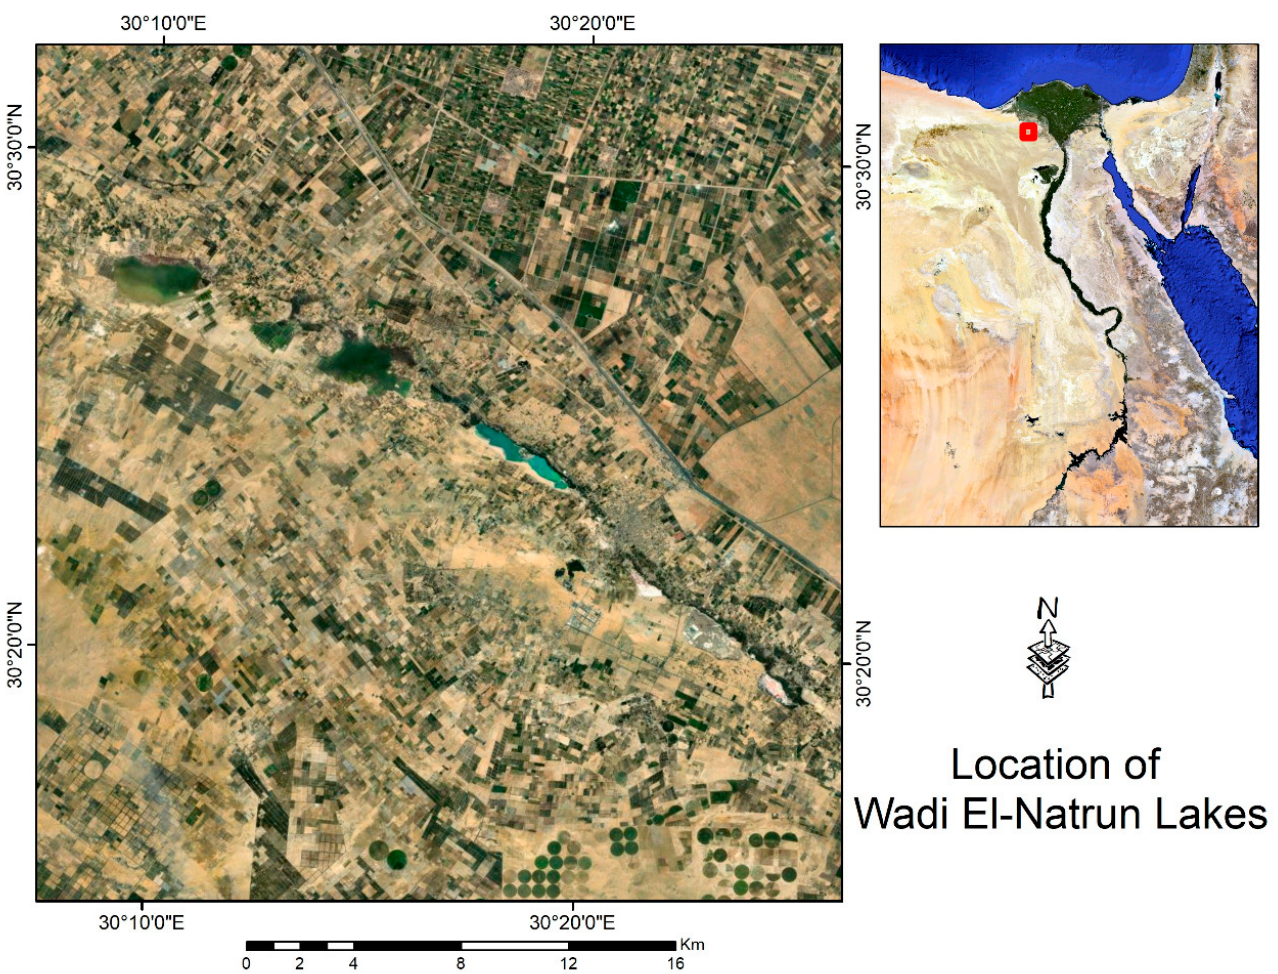
Figure 1. The sample-collection location ( Egypt’s Wadi Al-Natrun from Soda Lake and Ga’ar